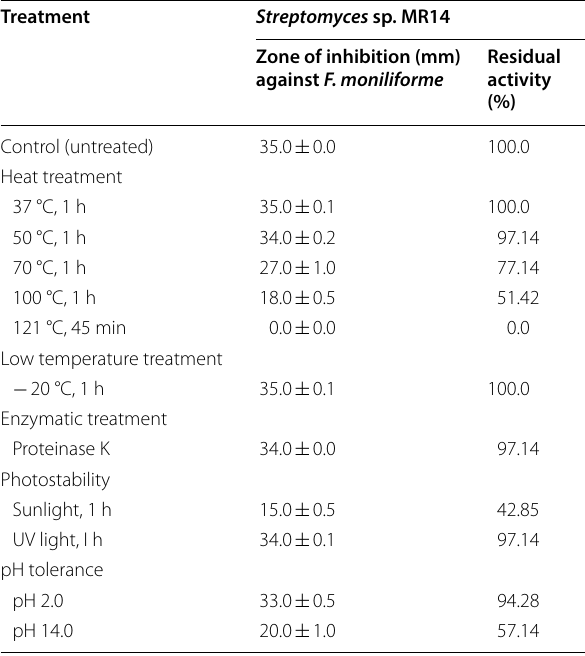
Table 3 Effect of temperature, pH, light and enzymatic treatments on the antifungal activity of culture supernatant of Streptomyces sp. MR14